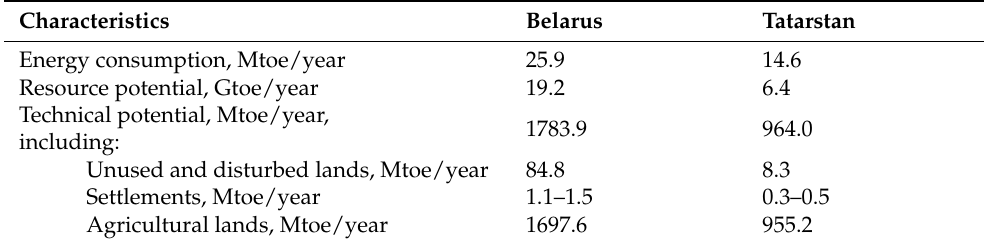
Table 3. Resource and technical potential for using solar energy in Belarus and Tatarstan.